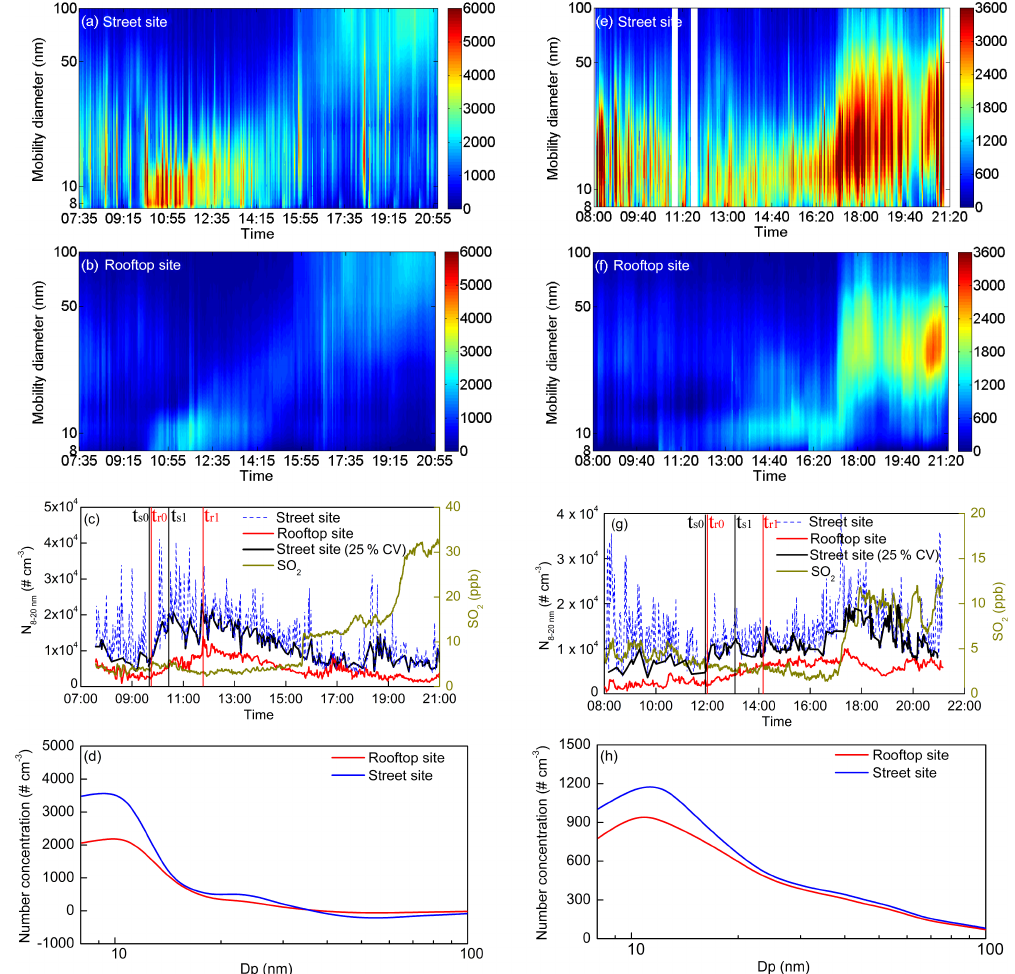
Figure 5. Contour plots, time series of number concentrations, and size distributions of atmospheric particles at two sampling sites on 22 December 2011 (left column) and 21 December 2011 (right column) ( a , b , e , f contour plots of particle number concentration (#cm − 3 ) ; c , g time series of nucleation mode PNC ( N 8–20nm ) and SO 2 mixing ratios at two sampling sites; d , h size distributions of N (ts 1 ) – N (ts 0 ) at the street site and N (tr 1 ) – N (tr 0 ) on the